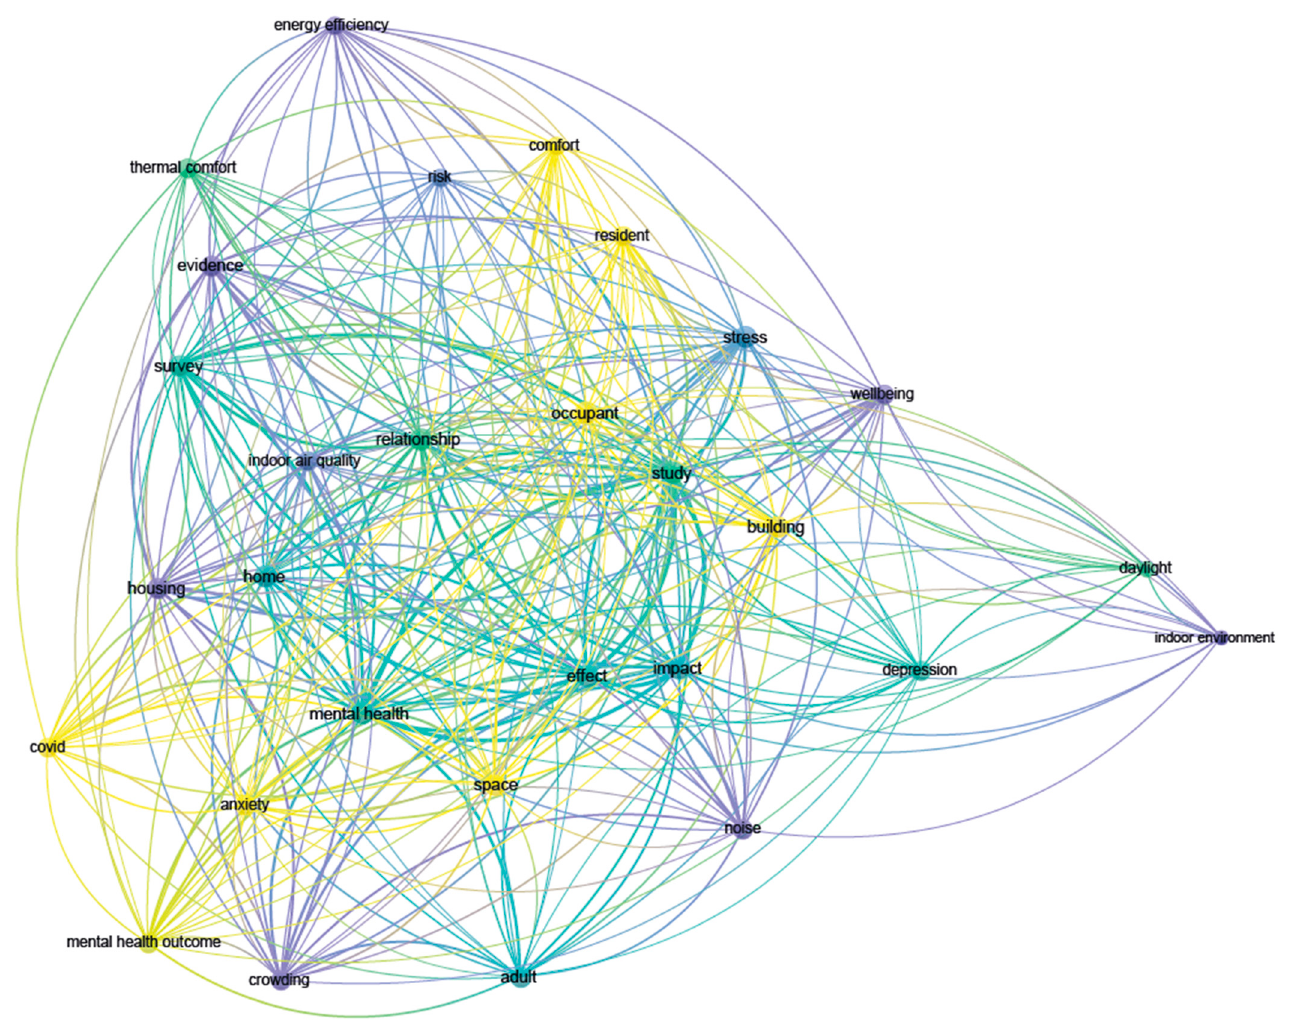
Figure 6. Overlay visualization: average publication year from VOSViewer. The colors indicate the average publication year: purple (2018), green (2019), yellow (2020).